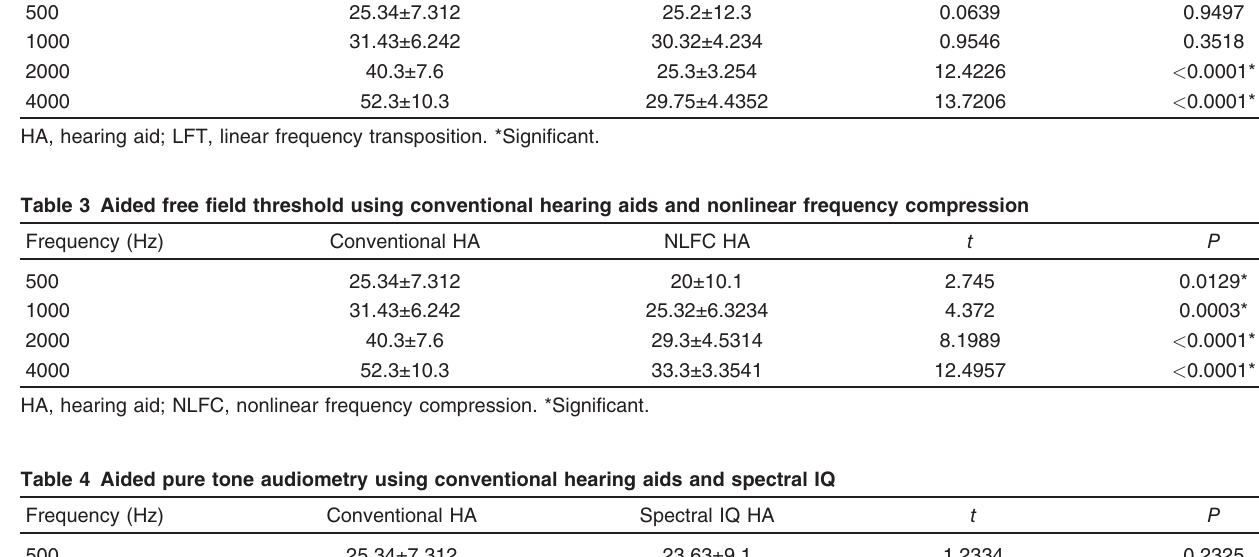
Table 2 Aided free field threshold using conventional hearing aids and linear frequency transposition Frequency (Hz)